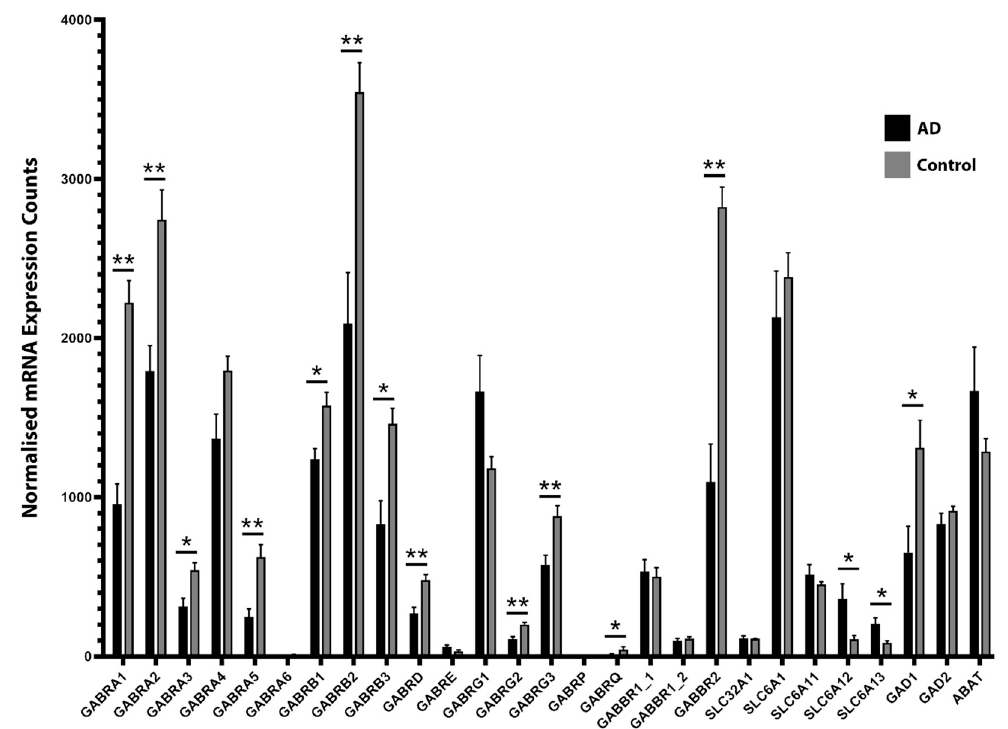
Figure 1. Normalized NanoString nCounter mRNA expression counts for γ -aminobutyric acid (GABA)ergic signaling components in Alzheimer’s disease (AD) and control human middle temporal gyrus (MTG) grey matter samples. Several GABAergic signaling components, including GABA A R subunits, the GABA B R2 subunit, GABA transporters, and the GABA synthesizing enzyme GAD 67 , are altered in expression in the AD MTG. Raw mRNA counts were normalized to positive control and housekeeping gene counts and background-corrected using negative control counts. For each subunit, normalized mRNA counts were compared between AD and control groups using the Mann–Whitney unpaired test, * p ≤ 0.05 and ** p ≤ 0.01. Data presented as mean ± SEM, n = six AD cases and six control cases. Gene names on x -axis; GABBR1_1 and GABBR1_2 represent two distinct transcript variants encoded by the GABBR1 gene.